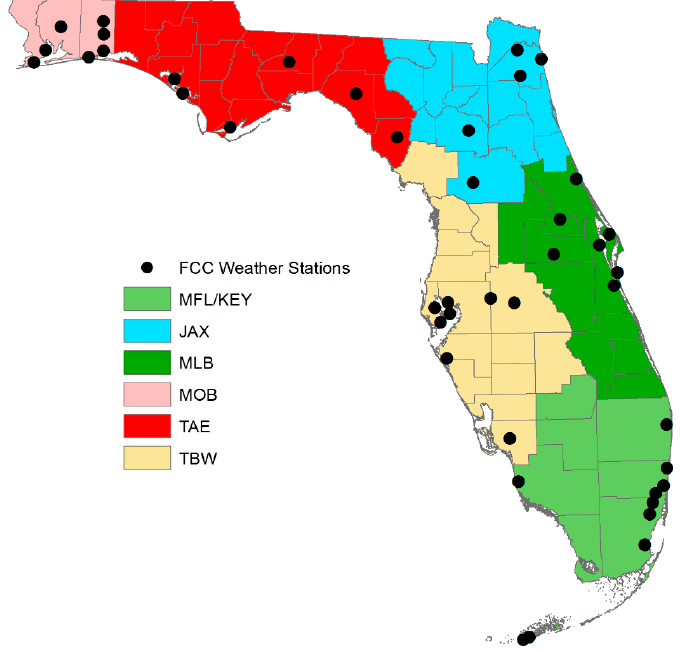
Figure 1. National Weather Service regions and locations of Florida Climate Center monitors within Florida.